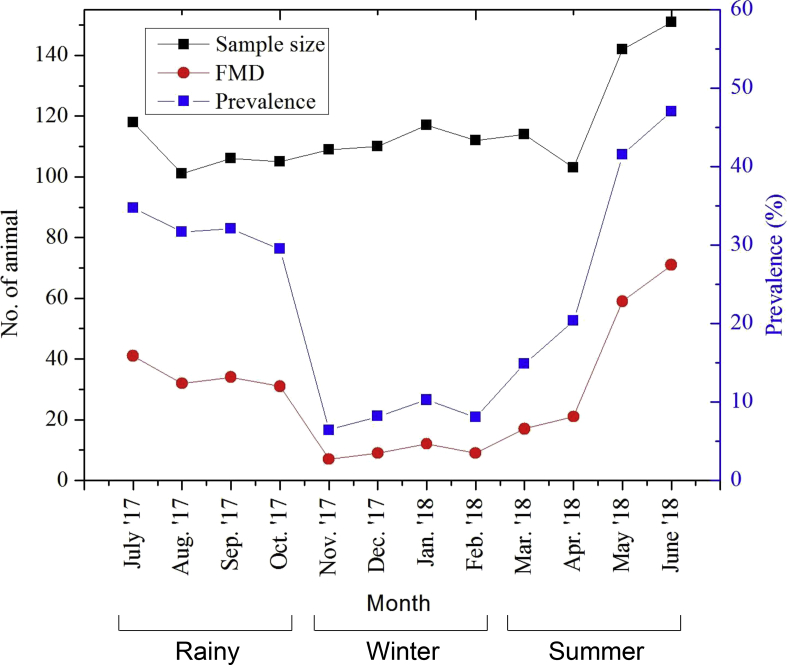
Temporal distribution of FMD cases officially recorded in Upazila Livestock Office, Sulla. This graph illustrates the monthly prevalence against FMD from July 2017 to June 2018.